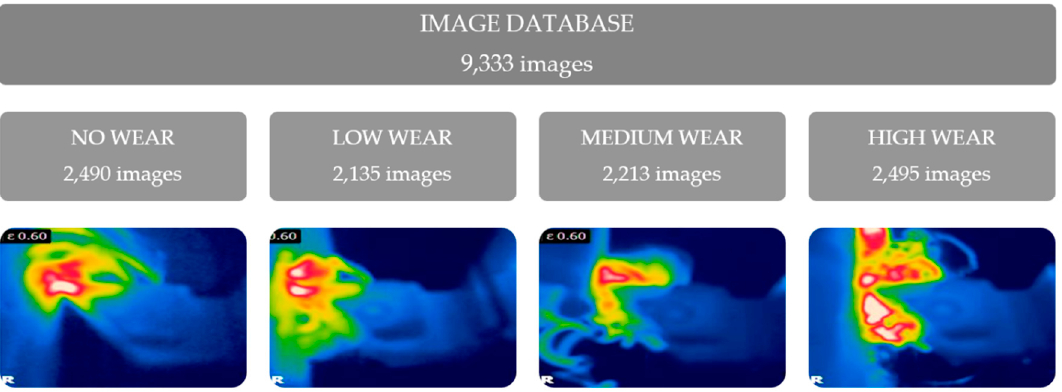
Figure 7. The categorisation of the acquired images into wear classes. Table 6. The number of images in the training and test sets categorised by the wear